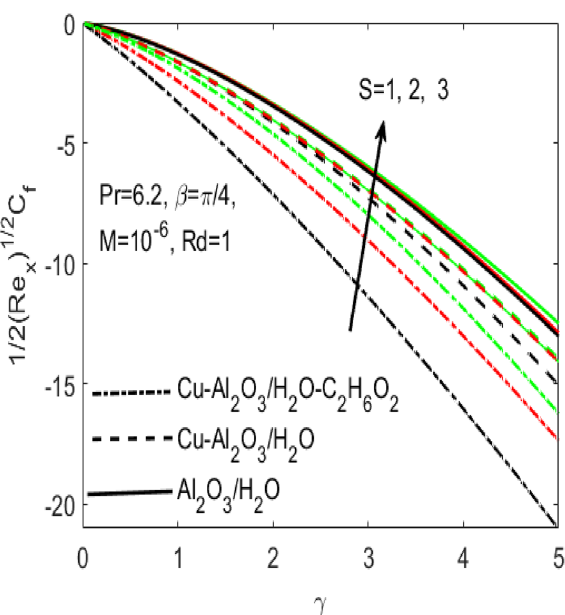
Figure 11. Influence of S on C f for different hybrid nanofluids and simple